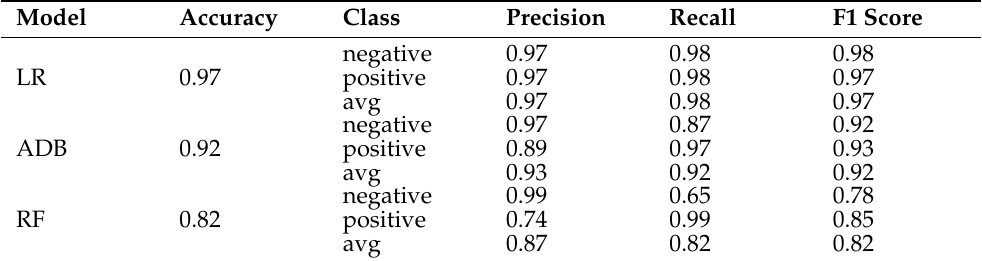
Table 12. Experimental results of ML models with TextBlob sentiments using BOW.